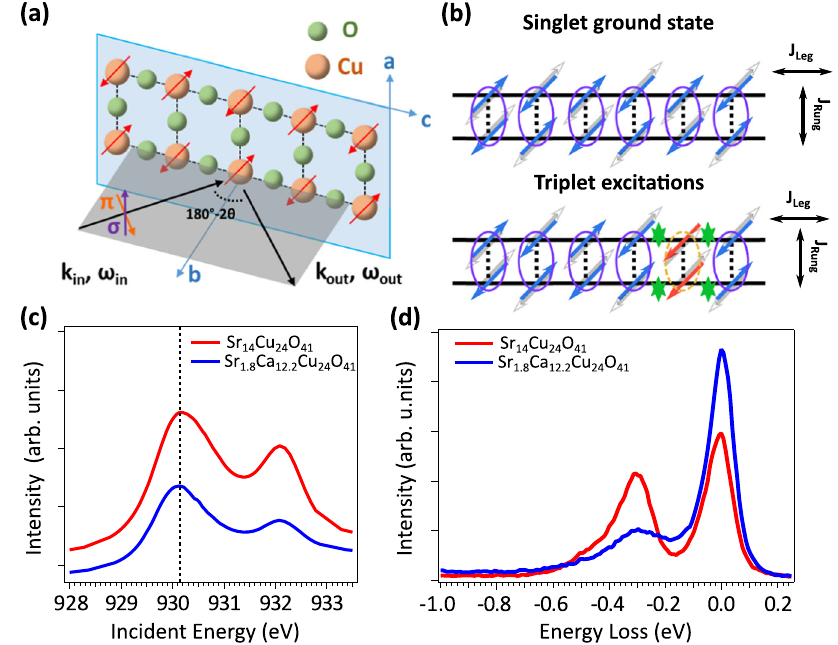
Fig. 1 Experimental overview and schematic of ladder triplon excitations. Schematics of ( a ) RIXS experimental geometry with the orientation of the two-leg Cu 2 O 3 ladders in SCCO. The ladder-leg direction is along c -axis, with lattice constant c leg ∼ 3.9 Å . b S = 1 triplon excitations (orange dashed-line ellipse) in two-leg quantum spin ladders. The local antiferromagnetic interactions along the ladder leg and rung are mediated by spins (blue arrows) with equal probability pointing along any directions (opposite direction denoted as gray hollow arrows). The rung-singlets (purple ellipses) interact through ladder-leg exchange coupling. c Main resonances of Cu L 3 -edge XAS. 3 d 9 white line is marked by the black dashed-line. d Cu L 3 -edge RIXS spectra taken at 3 d 9 peak at q leg ¼ (cid:1) 0 : 31 (rlu) in σ polarization. Here, a negative (positive) momentum transfer indicates the RIXS data taken in grazing incidence (emission)